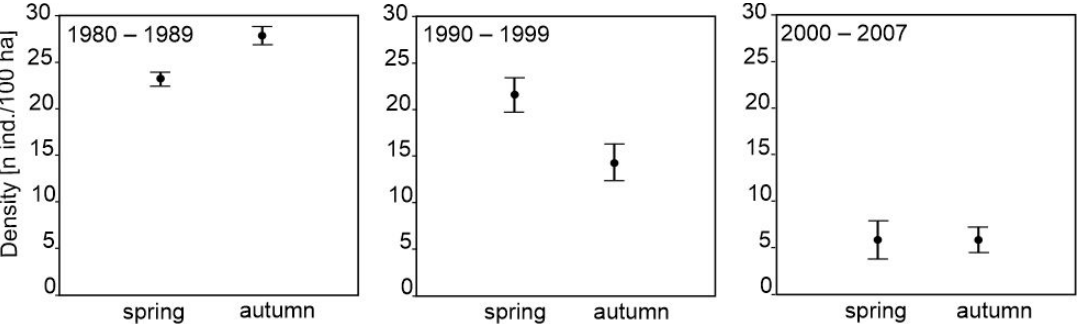
Figure 4. Mean ( ± SE) brown hare densities in spring and summer in Rog ó w (central Poland), as assessed with the aid of the belt assessment and spotlight counts along transect routes, in open fields, in the three study periods (1980–1989: n = 7; 1990–1999: n = 3, 2000–2009: n = 5). Data for spring and autumn of the same year were